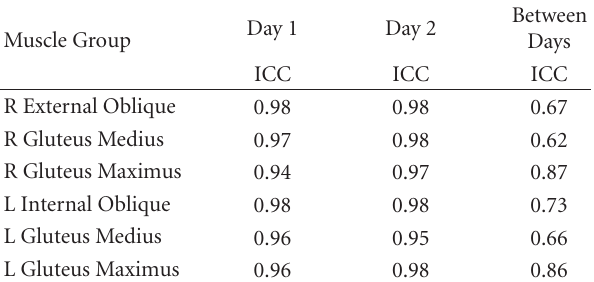
Table 7: Within-day and between-day repeatability for total gap length during